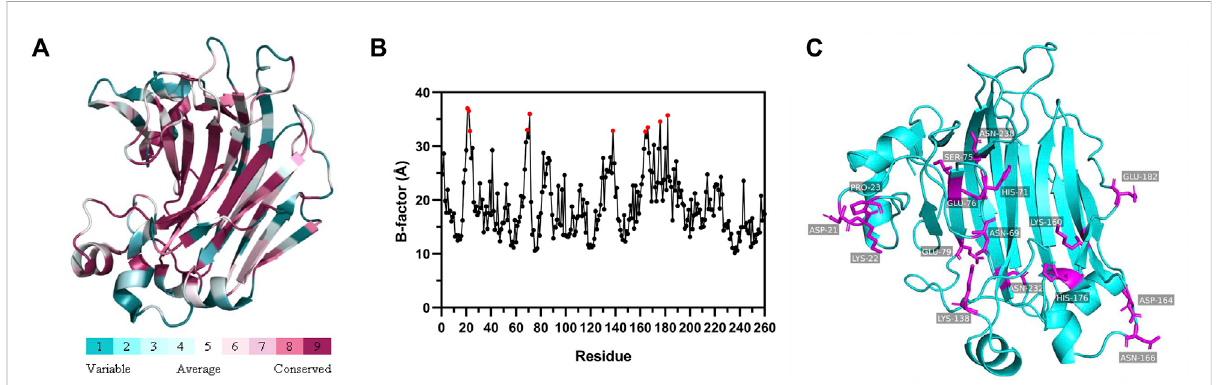
FIGURE 1 Flexible residues are determined based on the structure. (A) The evolutionary conservation is determined based on the structure and multiple sequence alignment.Theaminoacid residues arecolored ingradient representing theconservationgrades fromthemostvariable (turquoise) tothe most conserved (maroon) obtained with ConSurf program. (B) Identi fi cation of the fl exible residueaccording to the B-factor values of theWT FlAlyA determined from the crystal structure (PDB: 5y33). The top ten sites with B-factor value were selected as mutation sites and marked with red dots. (C) Spatial location of all mutation sites in WT FlAlyA. Mutation amino acid residues are shown as stick models and marked in